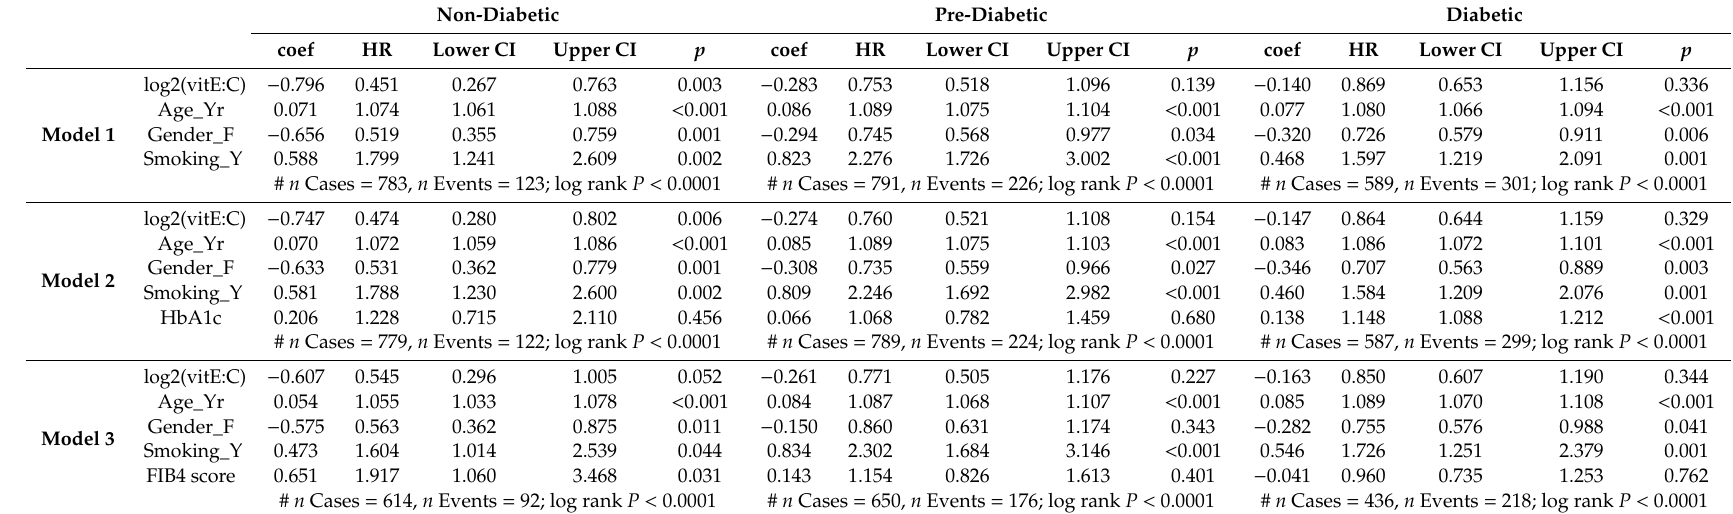
Table 3. Lipid-corrected vitamin E-based Cox regression models on overall mortality in three NAFLD groups stratified by diabetic